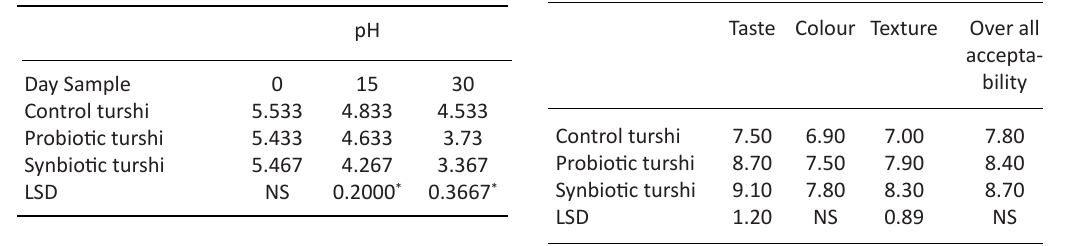
Table 2. pH of Control, Probiotic and Synbiotic turshi samples